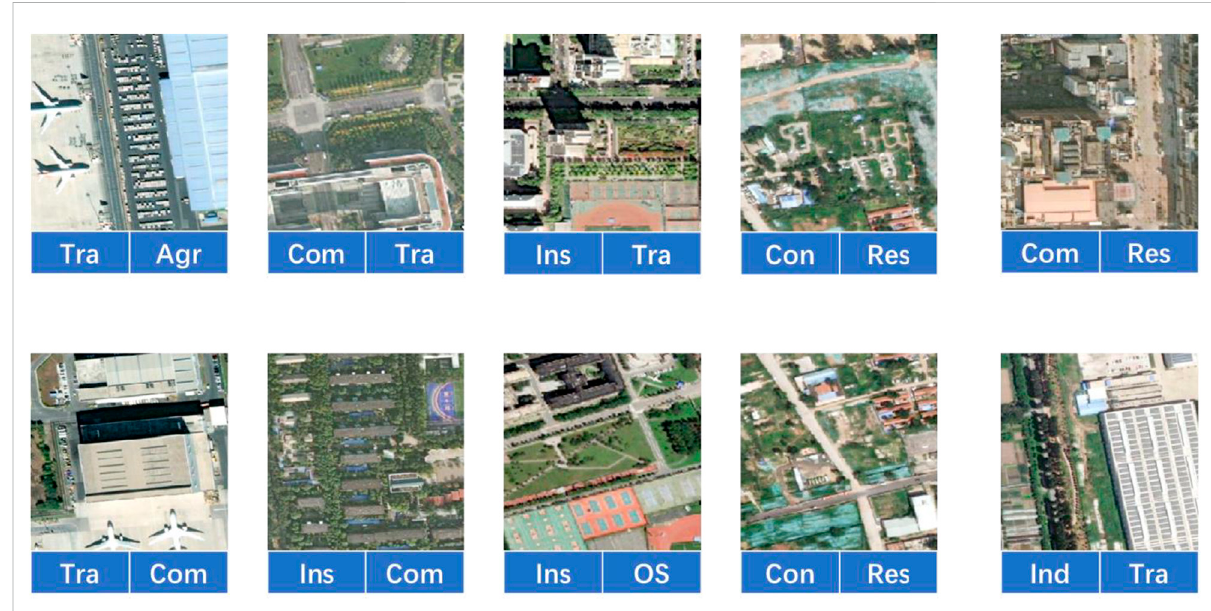
FIGURE 7 Samples misclassi fi ed by the model pretrained on AID. The texts at the bottom of each sub fi gure are the ground truth and the prediction. For example, the image in the left upper corner is for transportation, but it was misclassi fi ed as agricultural land. Com: commercial, Res: residential, Ins: institutional, Ind: industrial, Tra: transportation, OS: open space, Con: construction, For: forest, Agr: